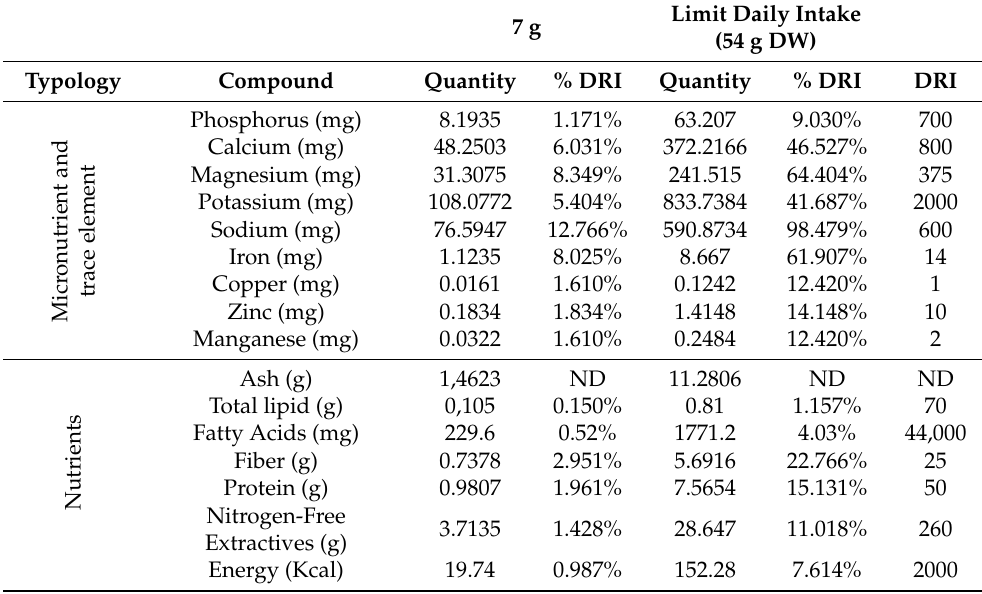
Table 11. Nutritional value in 7 g of S. polyschides according to the established Dietary